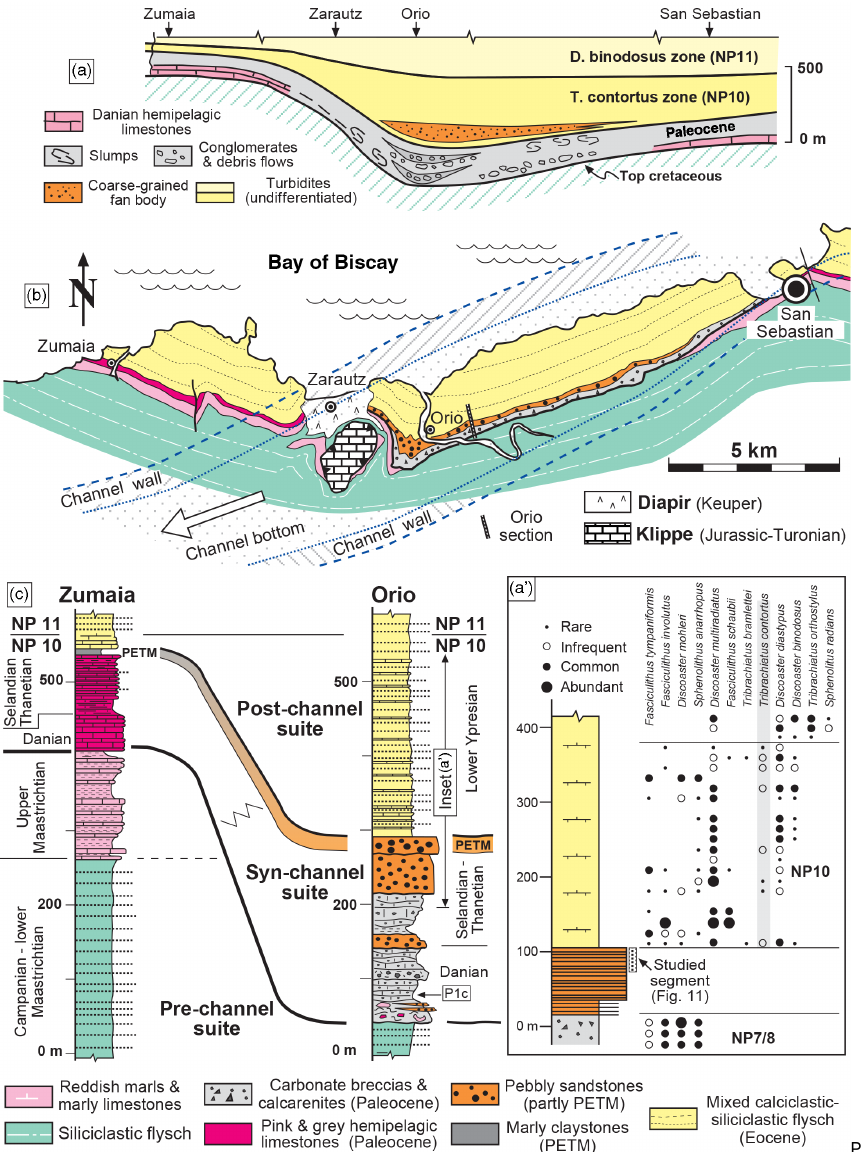
Figure 7. (a, a’) : stratigraphic cross section of the Zumaia–San Sebastian area and calcareous nannoplankton zonation of a part of the Orio section (after van Vliet 1982, redrawn from his Fig. 60 and his enclosure 3). Note that the Cretaceous part in the cross section is undifferentiated. Panel (b) : outcrop map with superimposed paleogeography of a segment of the Paleocene deep-sea channel from the same area (location: box 2 in Fig. 1). Panel (c) : correlation of the Orio and Zumaia sections using the NP10–NP11 boundary as